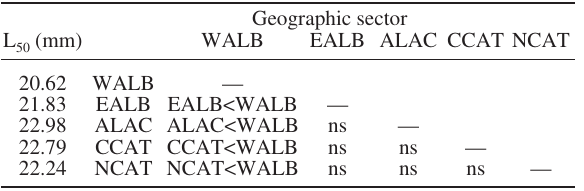
Table 4. – Post-hoc test among geographic sectors concerning the estimated size at 50% maturity (L ) in Pasiphaea sivado identified 50 by fitting a logistic function to the proportion of mature females by size (Fig. 4)